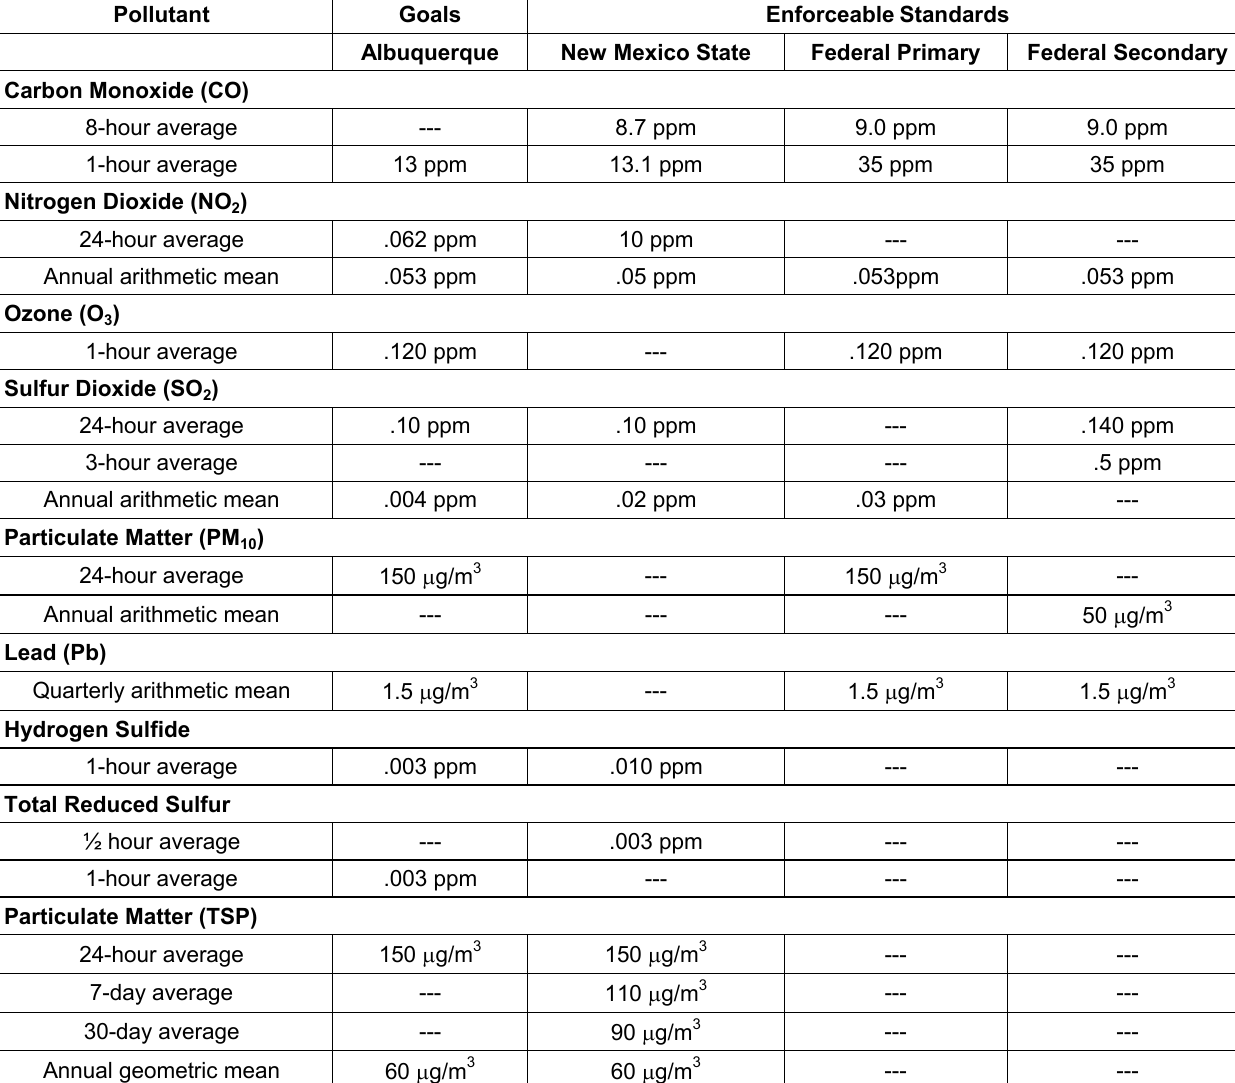
Table 9. Enforceable standards for various air